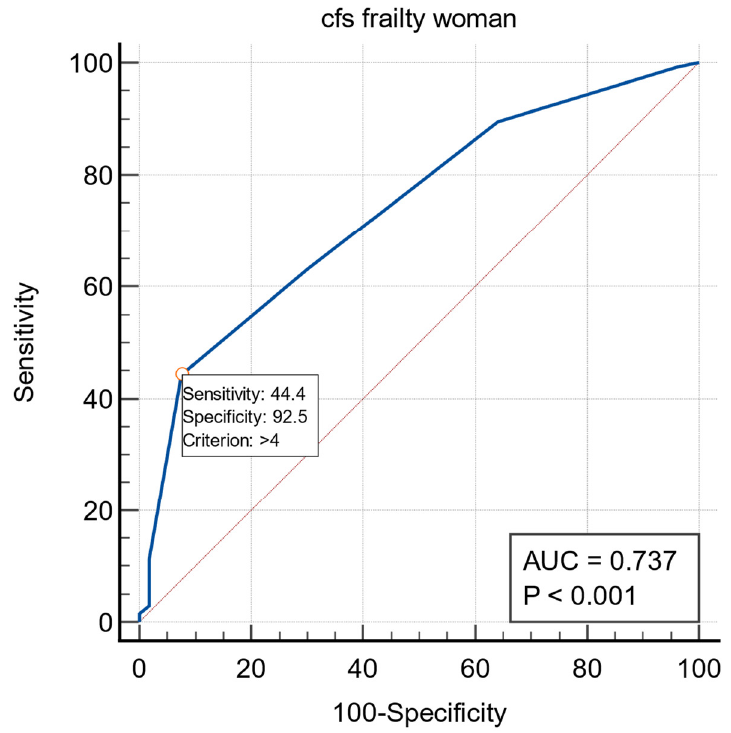
Figure 4. The ROC curves for frailty in the dislodgement in female subgroup. Table 3. Detailed results of logistic regression—male